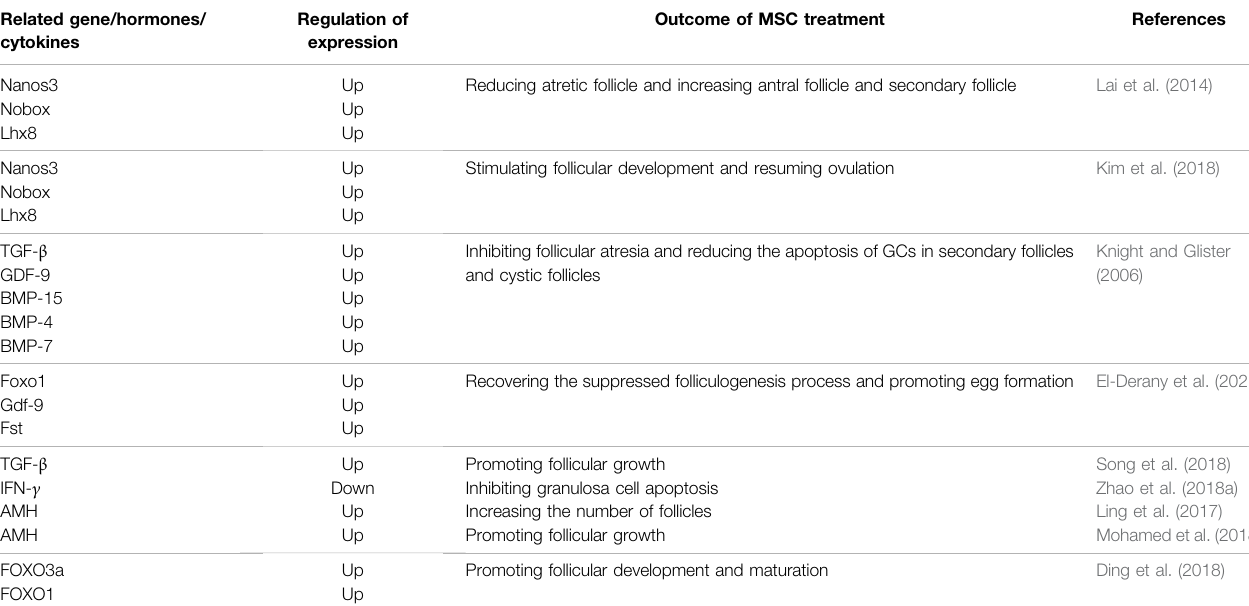
TABLE 2 | The effects of MSCs on follicular